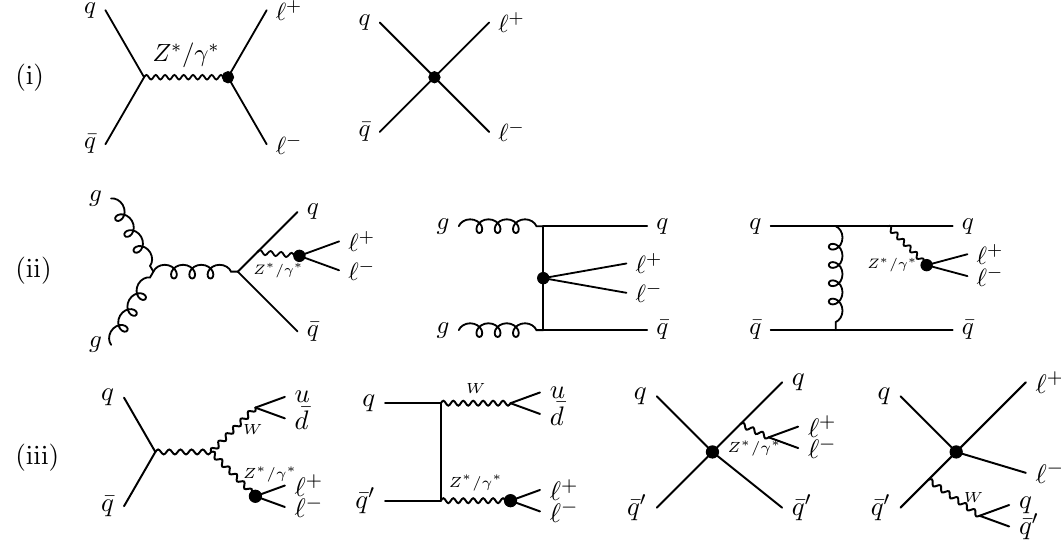
Figure 5 . Illustrative subset of the diagrams contributing to the three processes studied in sec- tion 10.5. The dots indicate the (possible) insertion of one of the three operators considered in the